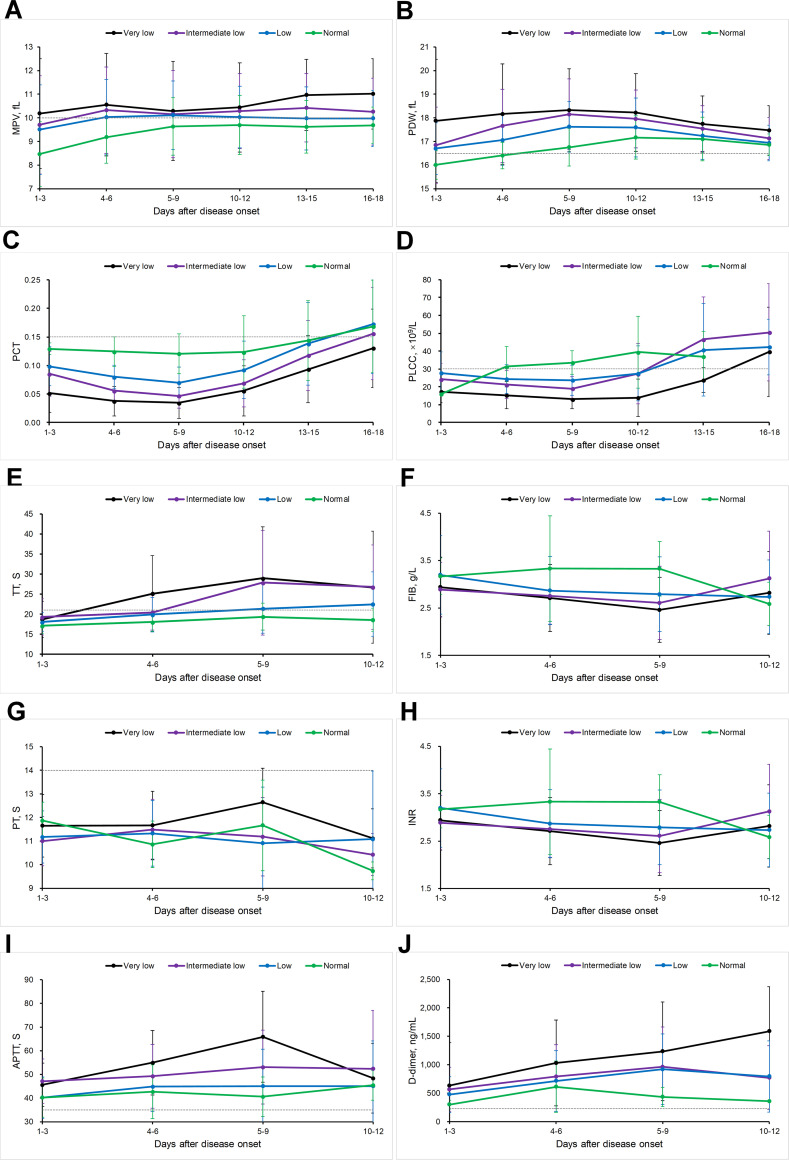
The profiles of platelet related laboratory parameters in the four groups with different PLT counts.A, MPV, mean platelet volume; B, PDW, platelet distribution width; C, PCT, thrombocytocrit; D, PLCC, platelet large cell counts. E, TT, thromboplastin time; F, FIB, fibrinogen; G, PT, prothrombin time; H, INR, international normalized ratio; I, APTT, activated partial thromboplastin time; J, D-dimer. The mean and standard deviation were shown.